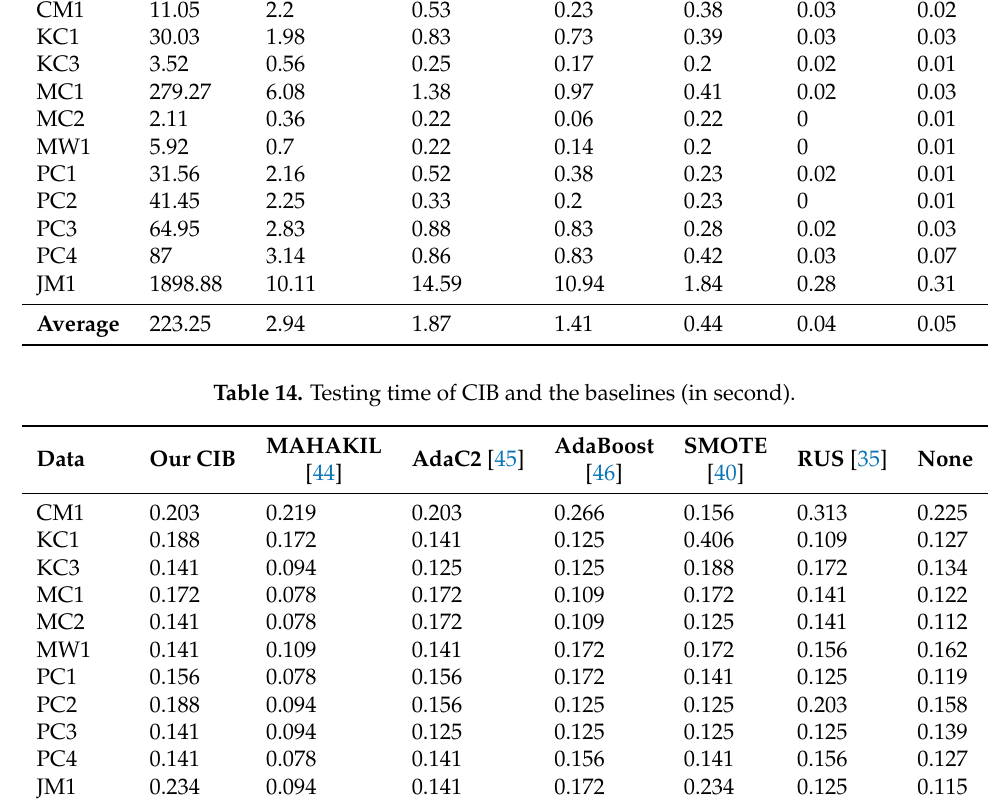
Table 13. Training time of credibility based imbalance boosting (CIB) and the baselines (in second). Data